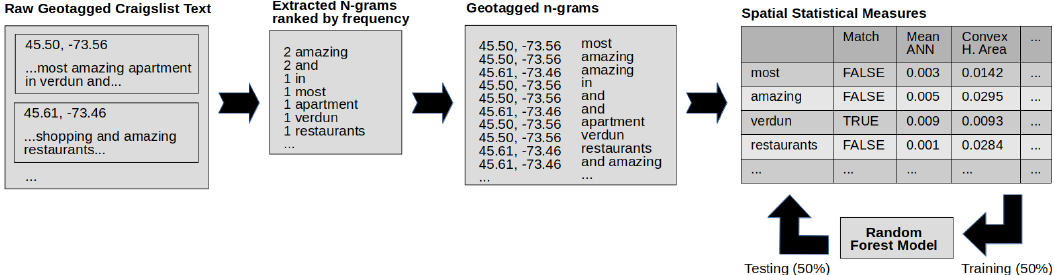
Figure 2. A flowchart showing the process and example data for the methodology in this work. Note that the data are simplified/rounded for example